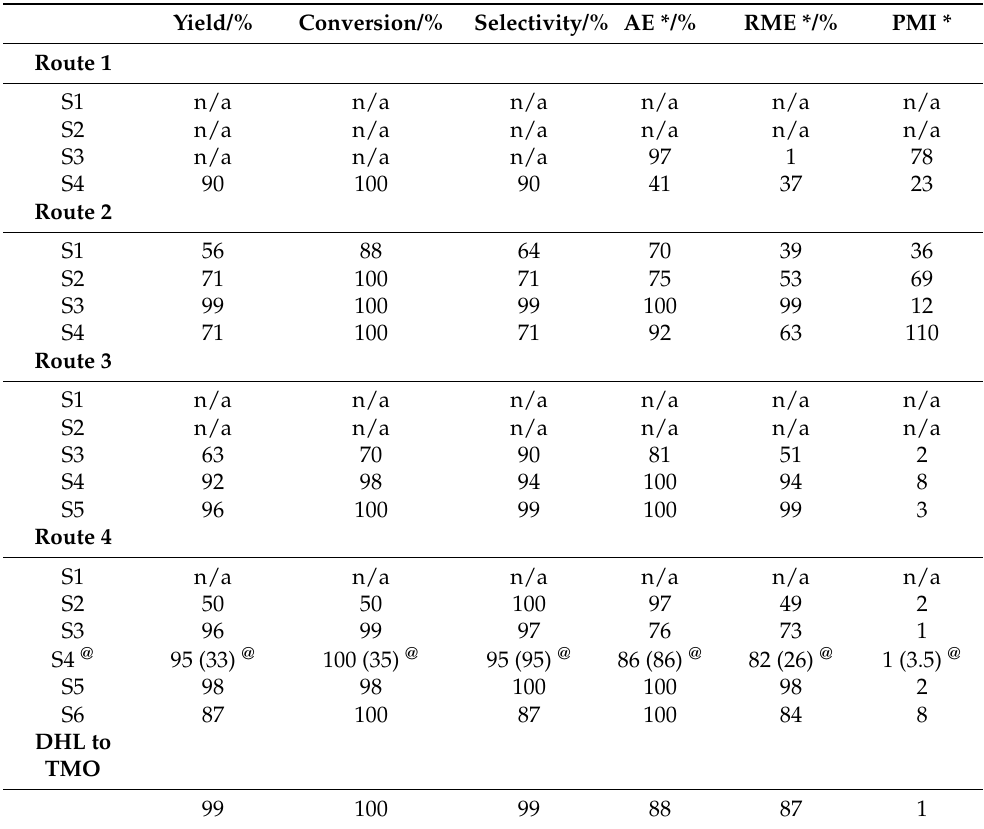
Table 2. Reaction metrics of each step (SX) of each Route (1 to 4) to DHL and subsequently to TMO as set out in Scheme